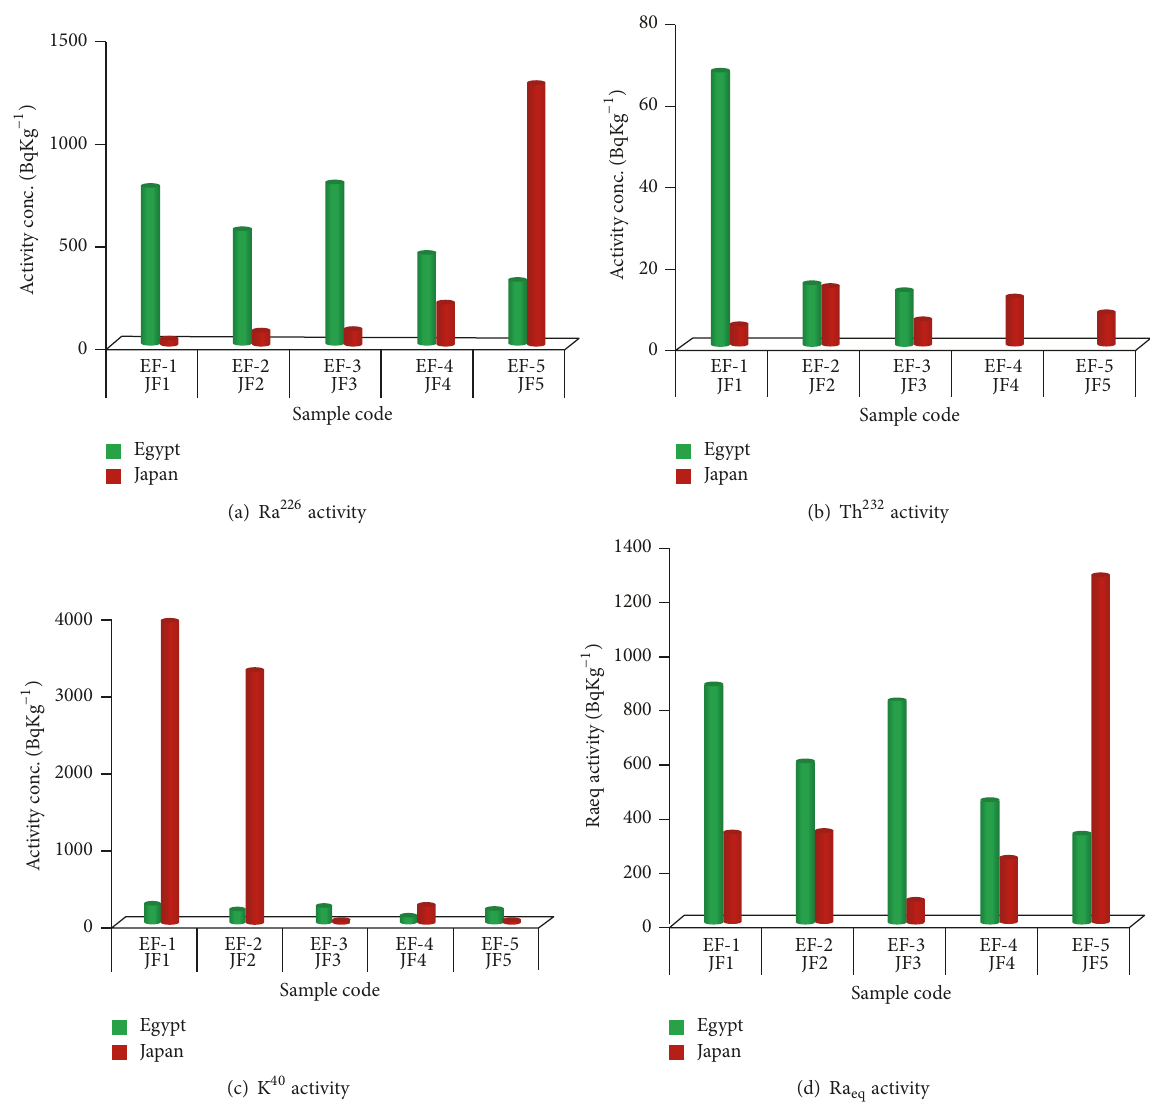
Figure 1: Comparison of natural radioactivities and radium equivalent of Egyptian and Japanese